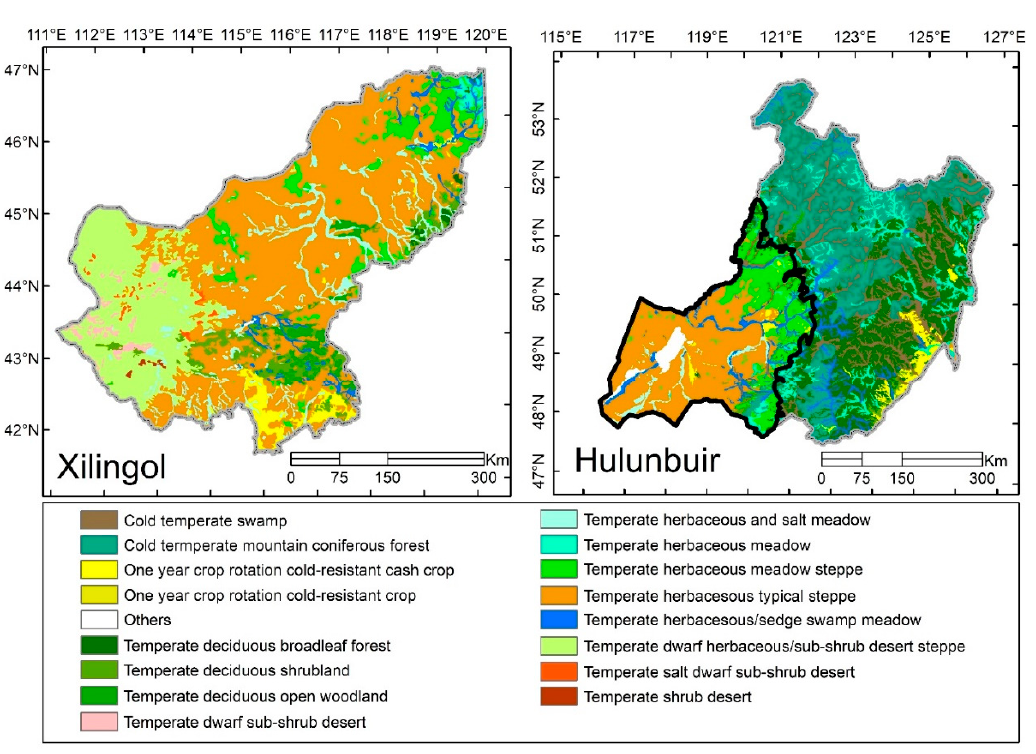
Figure 2. Vegetation types in the study area (reproduced according to Hou [28]).